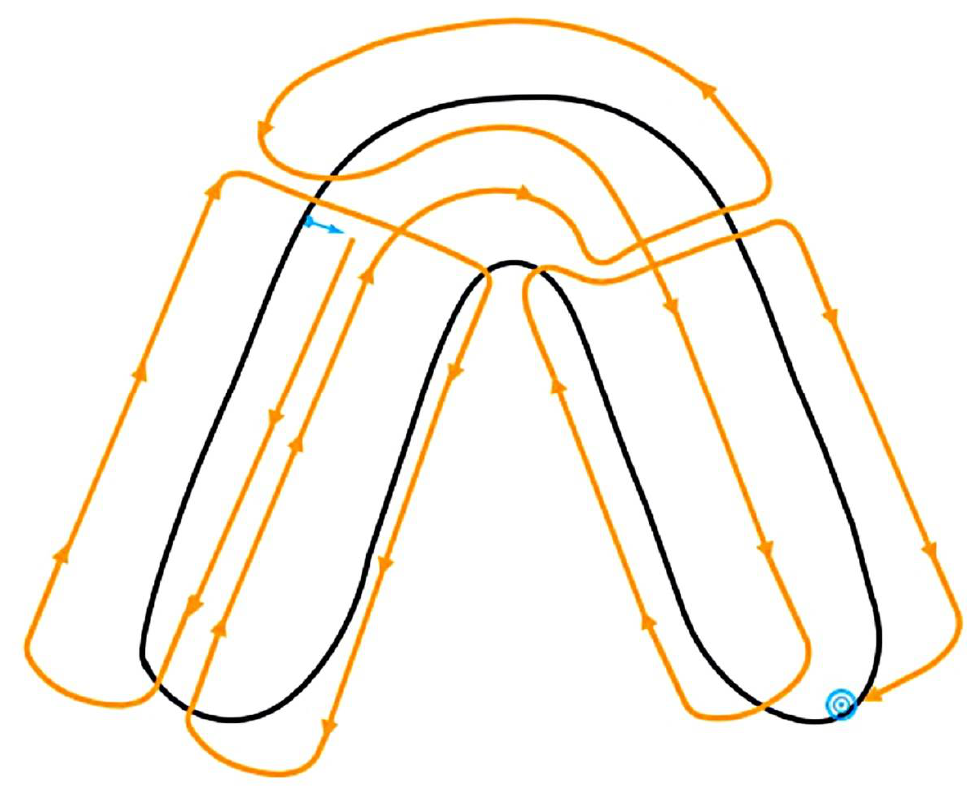
Figure 2. Scan path for the Cerec AC Omnicam. Blue arrow: start point, blue dot: endpoint. The bite registration was similar to the conventional workflow. After the actual bite registration, the wax plate was trimmed on one side, so that the buccal tooth surfaces and the buccal cusps of the lower and upper jaw were visible to the scanner. A buccal bite scan was performed with these modified bite plates in situ.